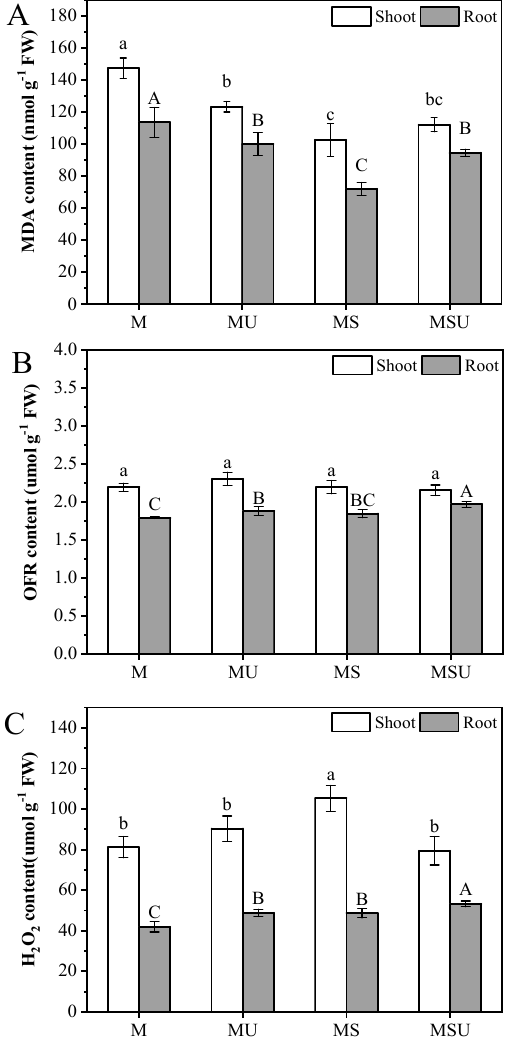
Figure 2. The contents of malondialdehyde (MDA) ( A ), oxygen free radical (OFR) ( B ), and hydrogen peroxide (H 2 O 2 ) ( C ) in shoots and roots under the different rhizobium treatments. M: M. sativa , MU: M. sativa + urea, MS: M. sativa + S. meliloti , MSU: M. sativa + S. meliloti + urea. Bars are standard error ( n = 3). Different letters stand for significant difference ( p < 0.05) with Duncan’s post-test.